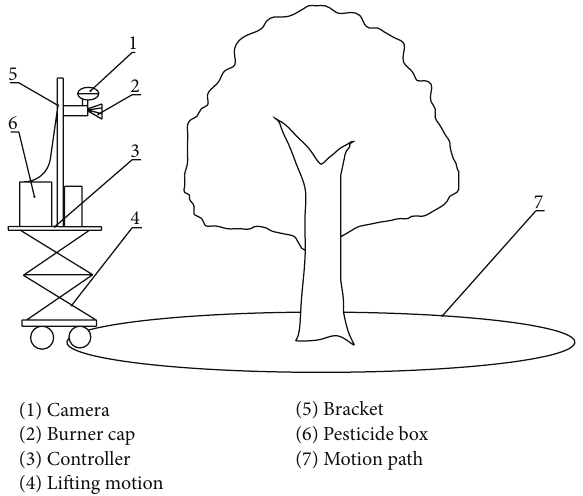
Figure 1: Sketch map of the relationship between the spraying device and plant location.